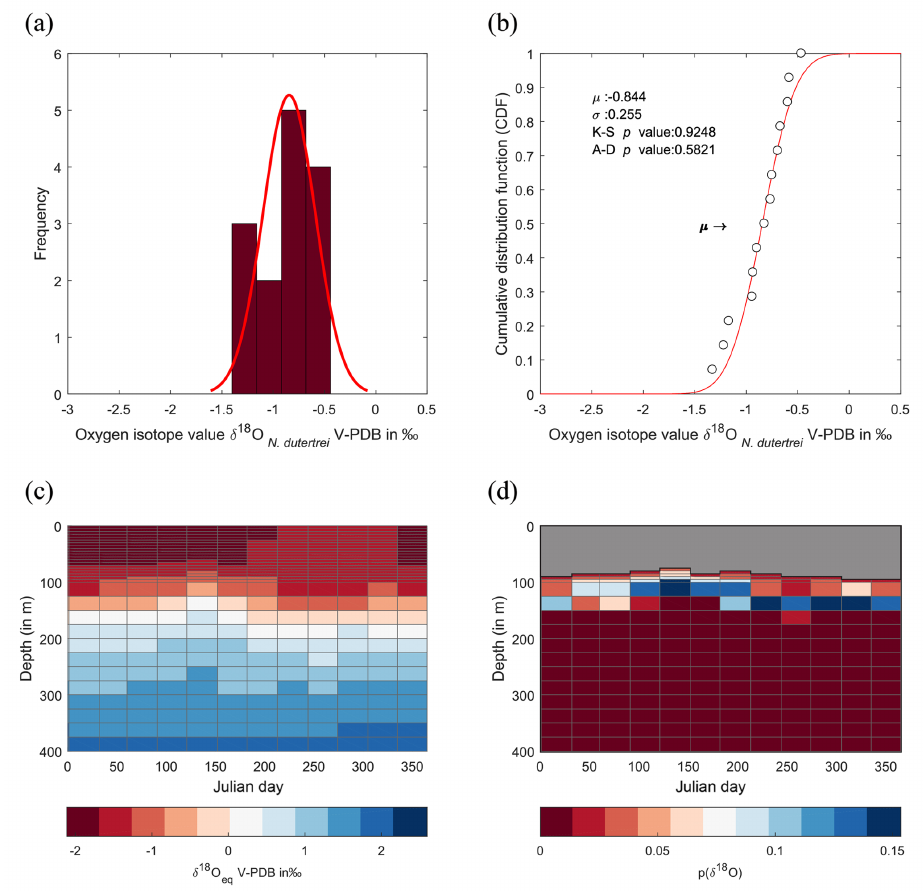
Figure 10. Calculated δ 18 O probability ( p(δ 18 O ) ). As per Fig. 8, with individual isotope values, CDF distribution, WOA13 δ 18 O eq and resultant p(δ 18 O ) but with N. dutertrei